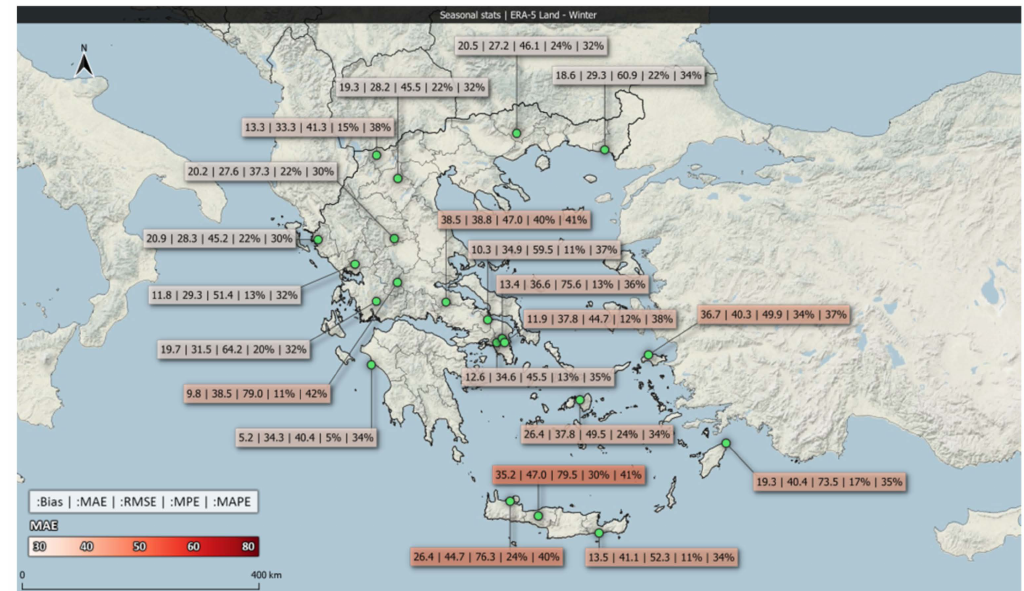
Figure 3. Bias (W/m 2 ), MAE (W/m 2 ), RMSE (W/m 2 ), and MPE and MAPE (both ranging from 0 to 1 for better visualization) between ERA5-Land and surface observations for winter (DJF) in the Greek